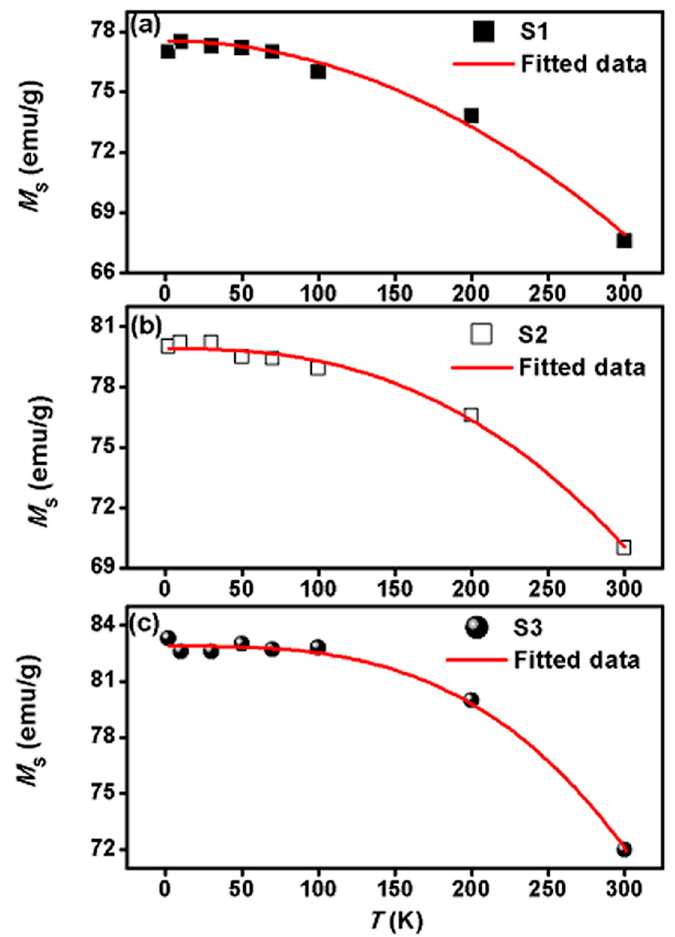
Figure 6. The temperature ( T ) dependent M S for samples ( a ) S1; ( b ) S2; and ( c ) S3, under zero field-cooling condition. The solid lines represent the fittings of the experimental data to a modified Bloch’s law. Table 1. The fitting parameters of the experimental data to a modified Bloch’s law 1 .